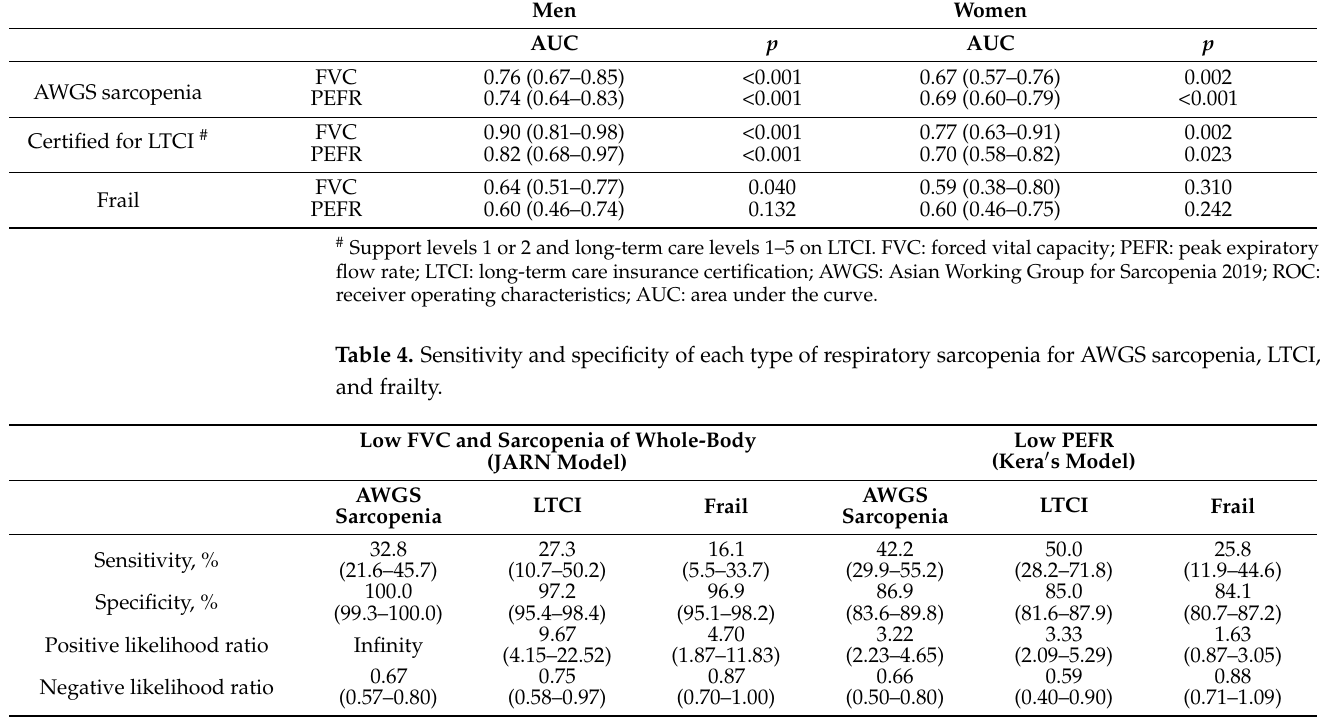
FVC: forced vital capacity; ASM: appendicular skeletal muscle mass; JARN: Japanese Association of Rehabilitation Nutrition; LTCI: long-term care insurance certification; PEFR: peak expiratory flow rate. Data are expressed as mean (95% confidence